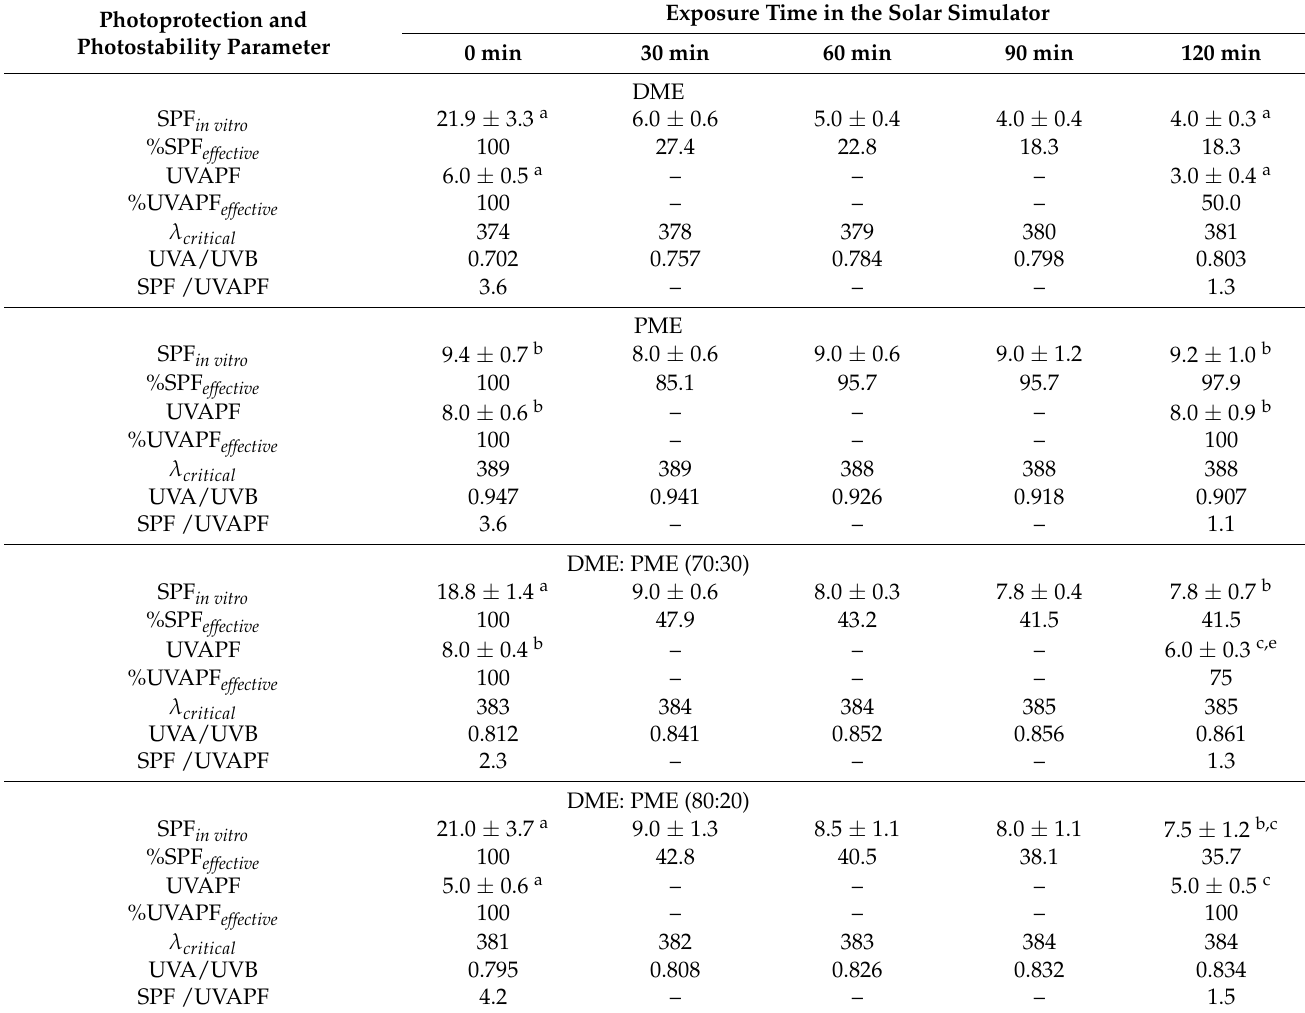
Table 2. Photoprotection and photostability parameters for formulations containing extracts and mixtures of